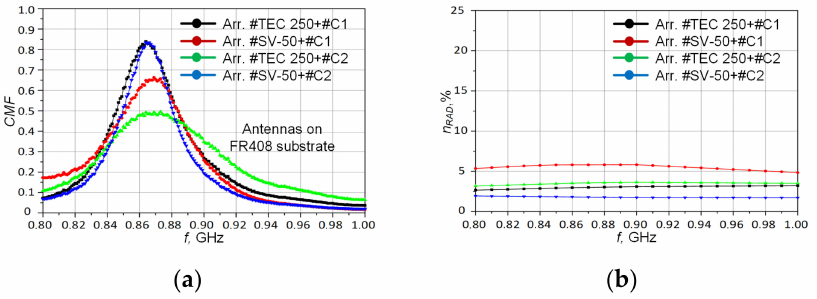
Figure 22. Parameters of RFID antennas: ( a ) CMF; ( b ) Radiation efficiency n RAD . It is also worth paying attention to the directional diagrams of the radiation